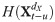
Simulated effects of changed source entropy on transfer entropy (TESPO).(A) TESPO for two simulated cases of high (H-high) and low (H-low) source entropy (**p < 0.01, error bars indicate the standard error of the mean, SEM, over data epochs). Dashed lines indicate the average TESPO estimated from the original data under 0.0% isoflurane ± SEM; (B) source entropy H(Xt-udX) (dashed bars) and target entropy H(Yt) (empty bars) for the two simulated test cases of high (gray bars) and low entropy (white bars), error bars indicate the SEM over data epochs. Source entropy was higher in the high-entropy simulation, while target entropy was approximately the same for both cases. Results are given as z-values across estimates for all epochs from both simulations.